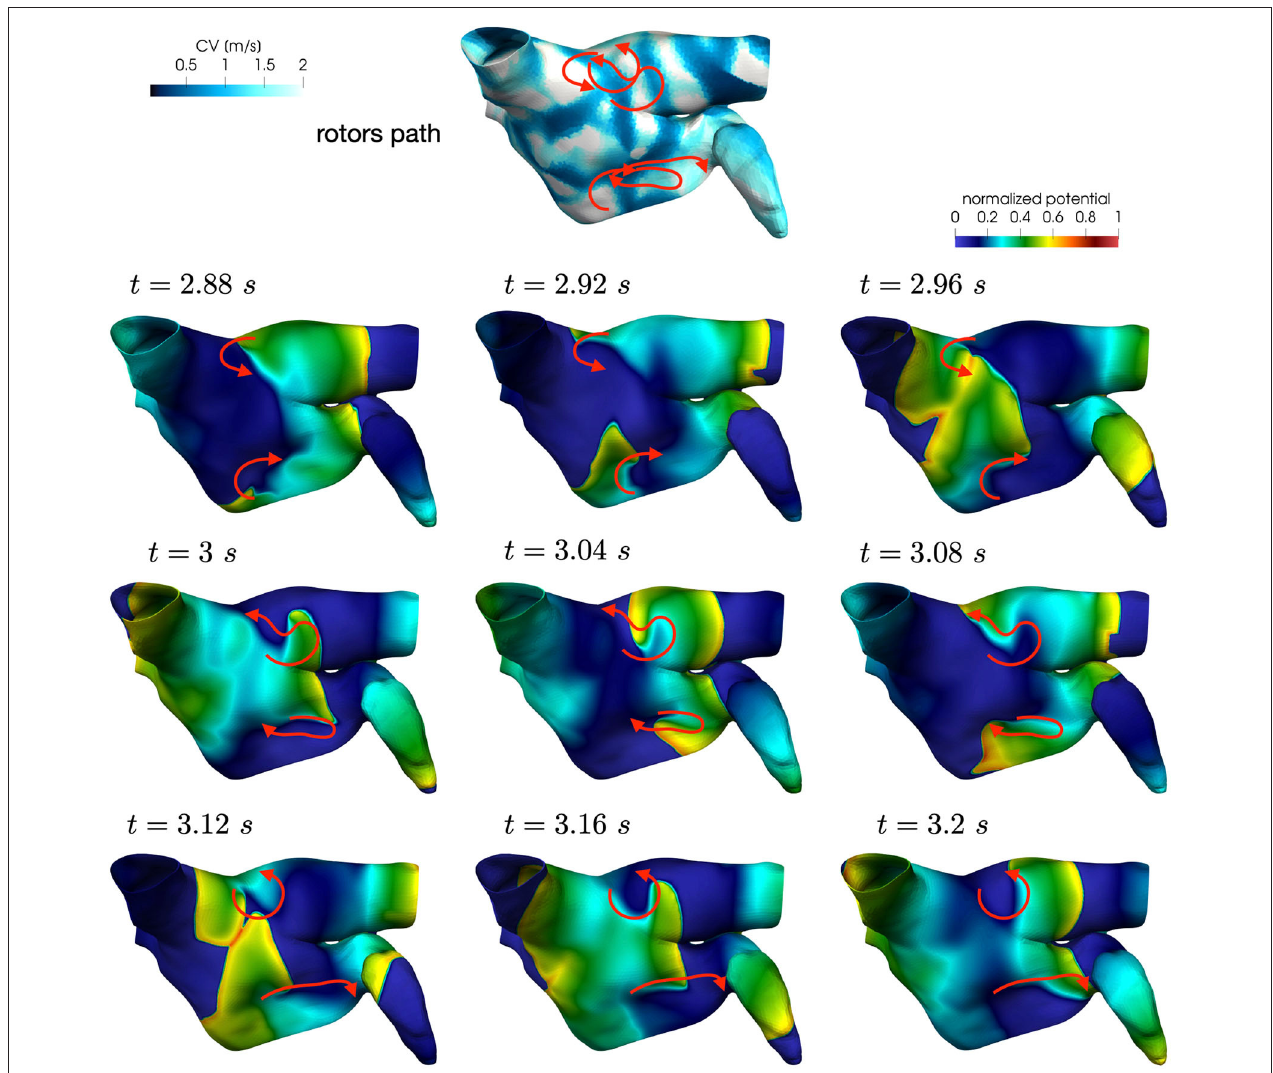
FIGURE 13 | Rotors position in unstable localized reentry in paroxysmal